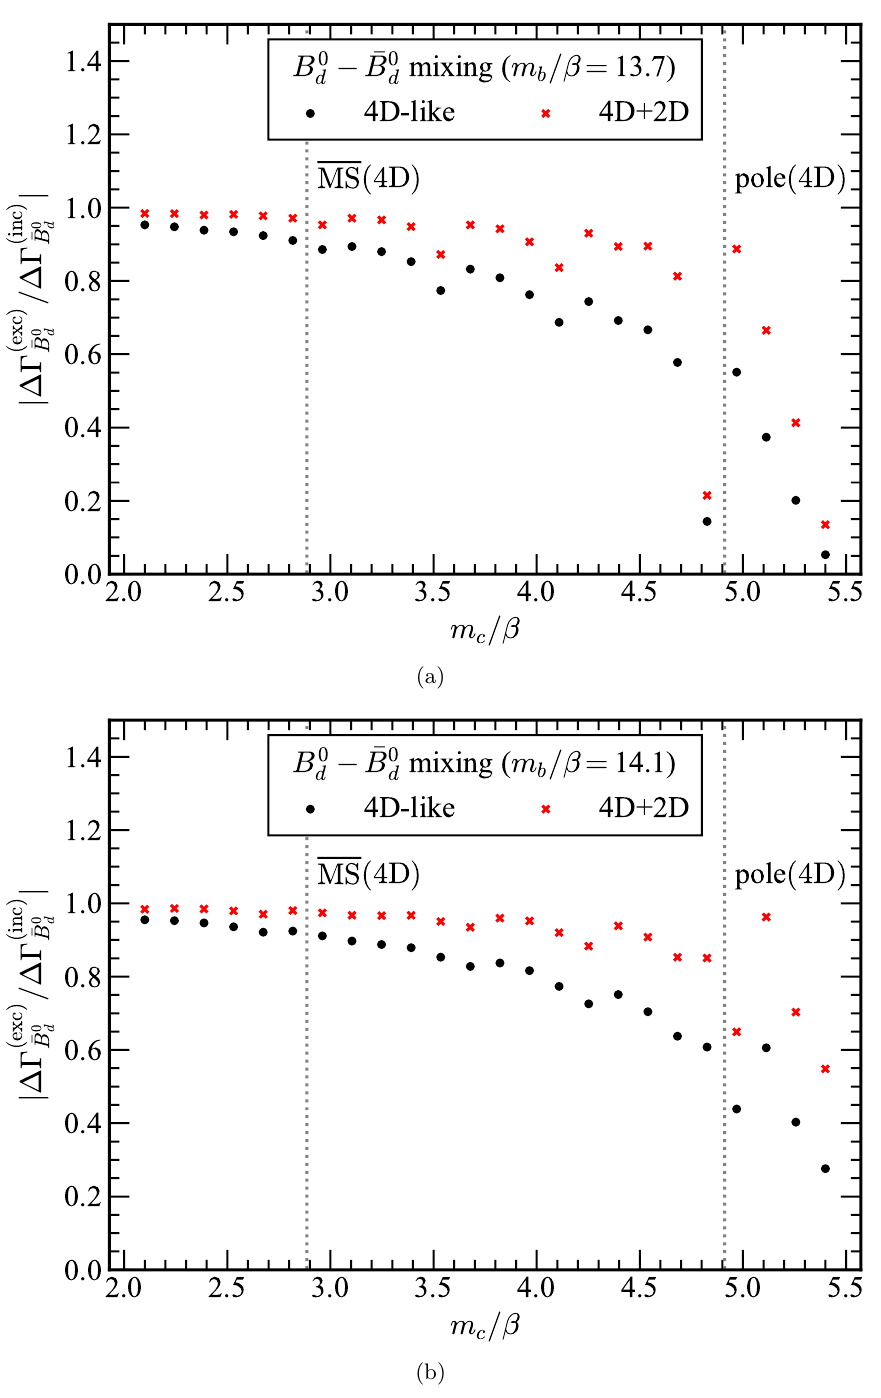
¯ mixing: (a) m − B 0 d d